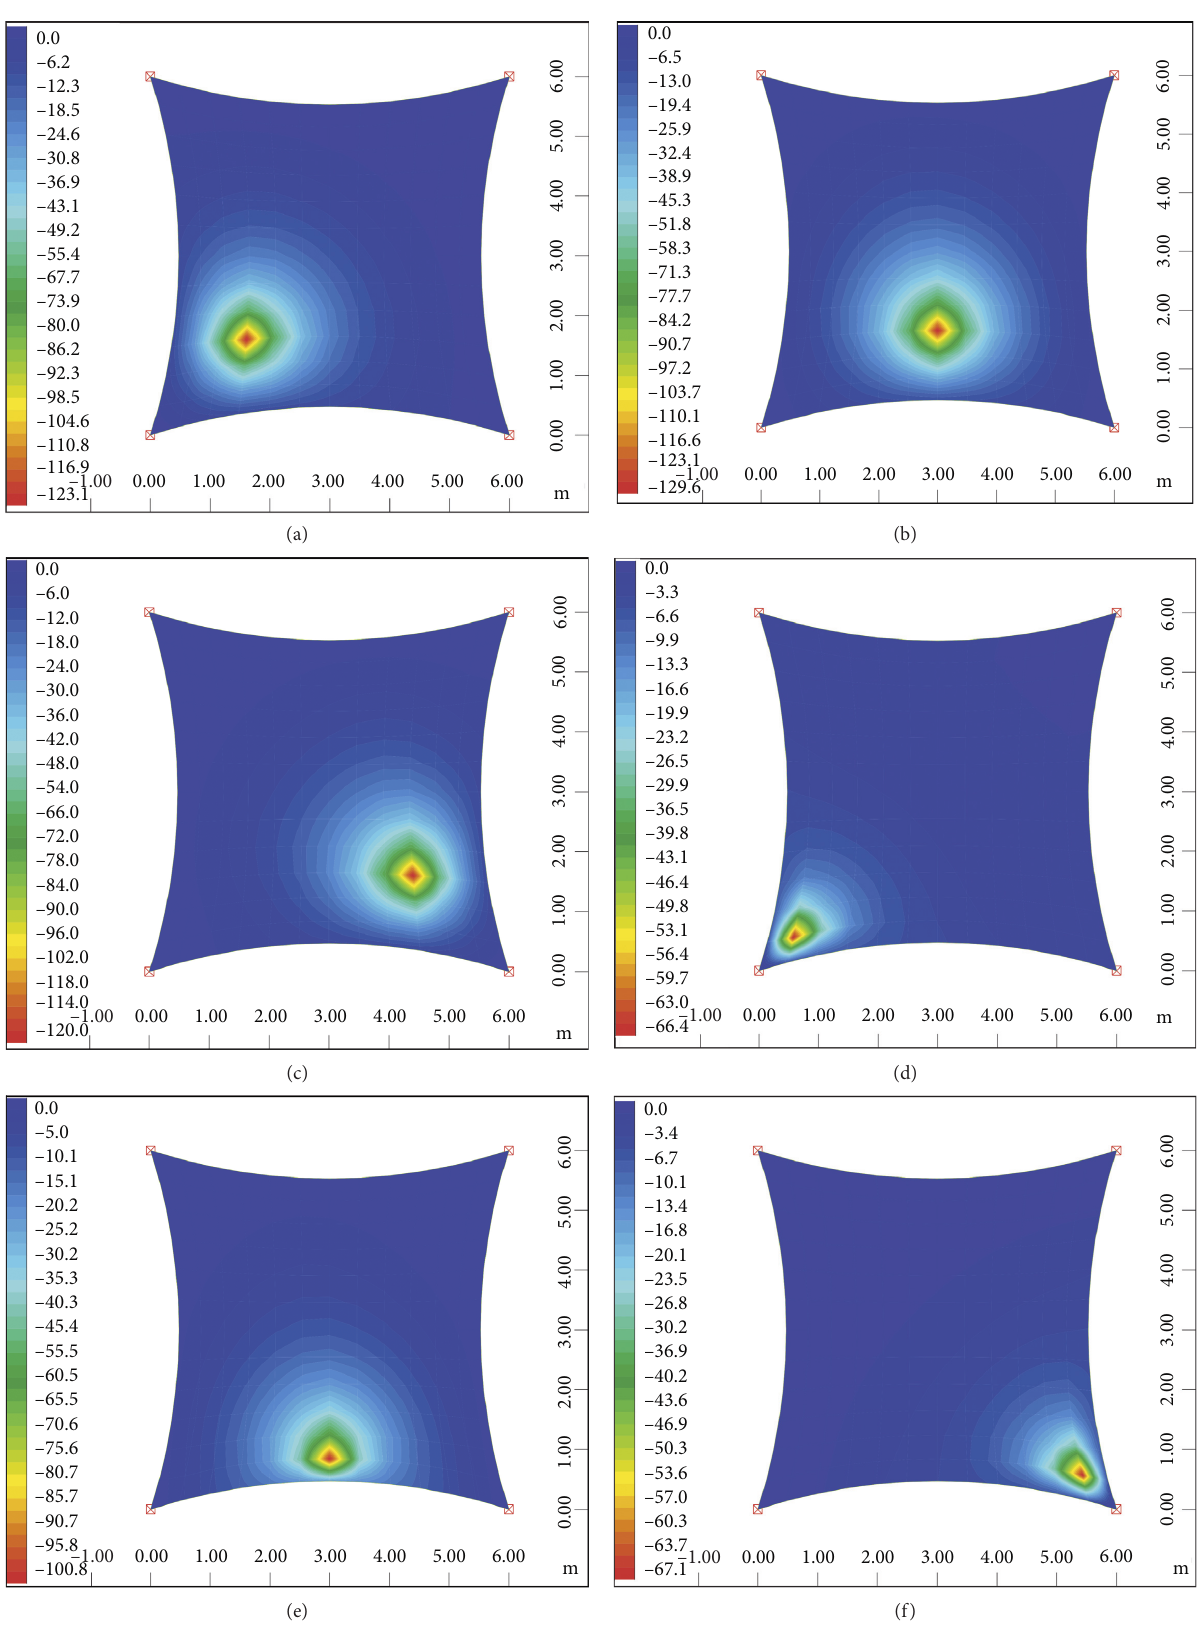
Figure 4: Membrane deflections of the initial model in global Z direction for 1kN point load acting in positions B to G (mm). (a) Point load position B. (b) Point load position C. (c) Point load position D. (d) Point load position E. (e) Point load position F. (f) Point load position